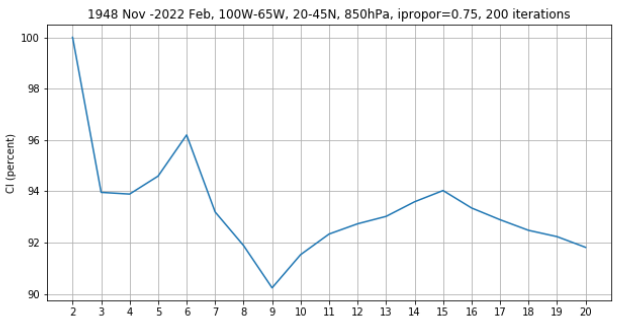
Figure 2. The classifiability index (CI) of the k-means clustering analysis using 850 hPa zonal and meridional wind component (u and v) in the Southeast U.S. and the surrounding region (100–65 ◦ W, 20–45 ◦ N) in the winter months (November–February) of 1948–2022; the optimum number for the k-means analysis is k = 6.